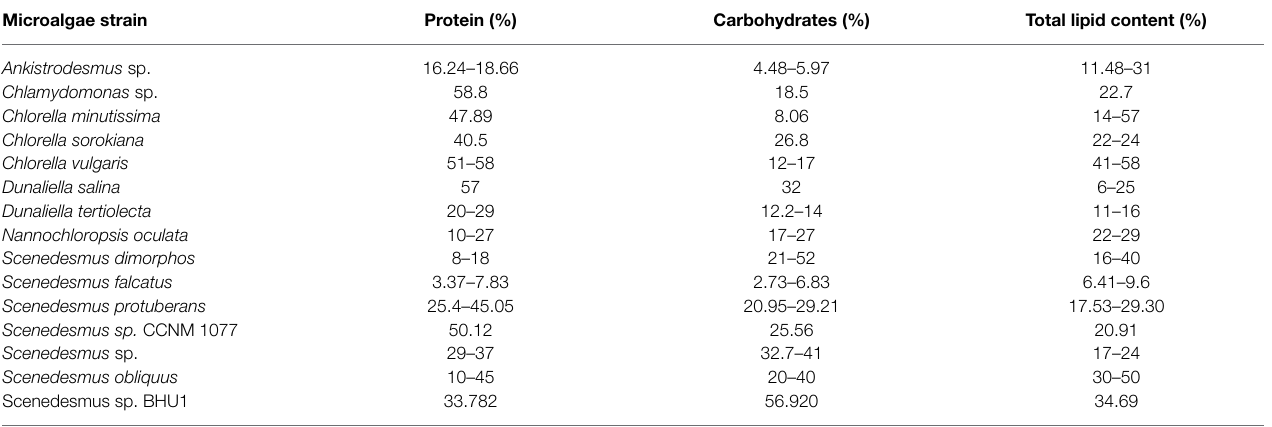
TABLE 2 | The biochemical content of green microalgae Scenedesmus sp. Microalgae strain Protein (%) Carbohydrates (%) Total lipid content (%) Ankistrodesmus